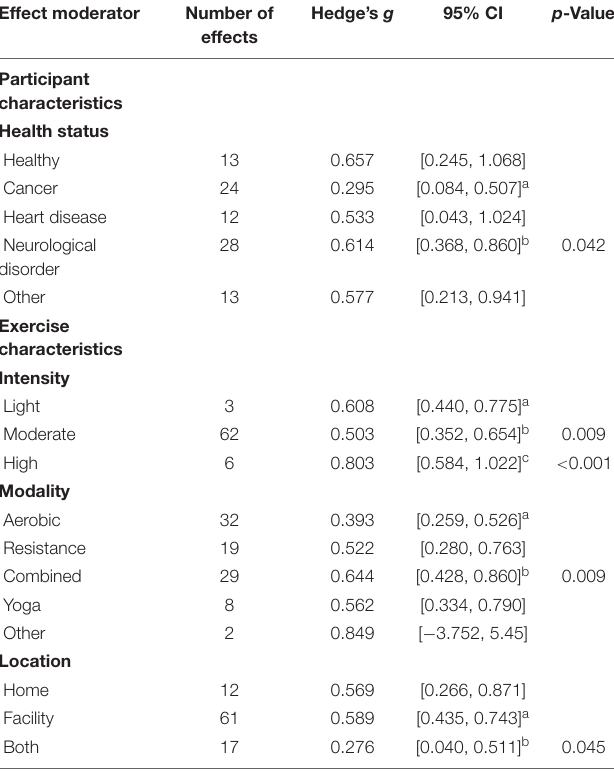
TABLE 5 | Univariate results for significant vitality categorical moderator